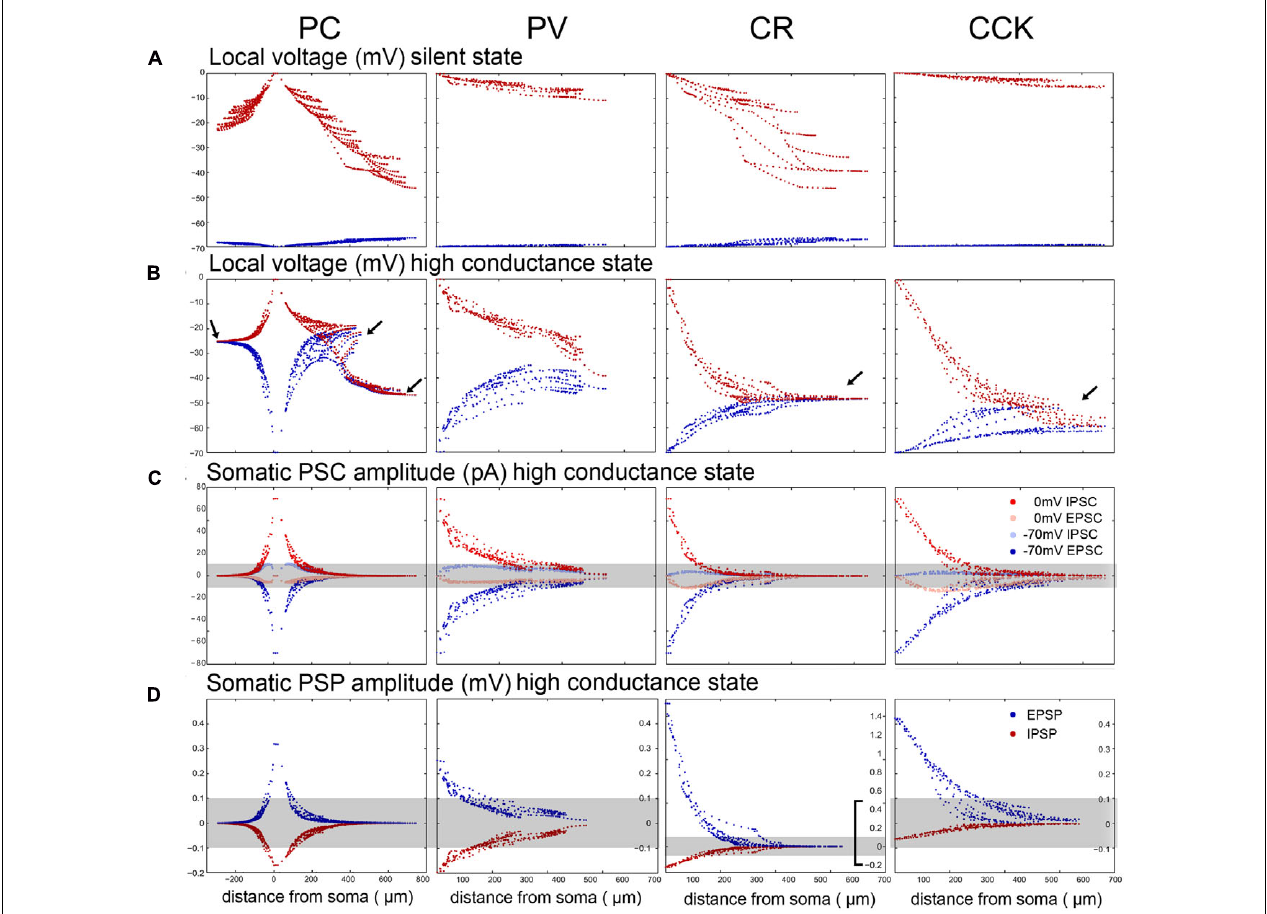
FIGURE 6 | VC measurement errors and somatic potentials are different in the 4 modeled neuron types. (A) The somata of the model neurons were clamped either to − 70 mV (dark red) or to 0 mV (dark blue) in the SS to show the breakdown of local clamped potential in different compartments. The breakdown is more severe when trying to clamp to 0 mV in all cell types, and it is much stronger in the electrotonically extensive pyramidal and CR cells than in the compact PV and CCK cells. (B) The breakdown of VC is considerably stronger in the HCS for all cell types. In the compact PV neuron the error is still relatively small. However, for the other cells the voltage converges over a short distance toward the equilibrium potential set by the local excitatory/inhibitory ratio (arrows). In the case of the relatively compact CCK cell the voltage converges toward a relatively negative potential because this cell receives the highest ratio of dendritic inhibition (see Figure 3 ). For PCs the convergence point is different for the oriens/radiatum dendrites and the lacunosum-moleculare dendrites, since the E / I ratio is different. (C) Comparison of somatically recovered EPSC and IPSC amplitudes at − 70 and 0 mV (the results for charge are quite similar, and are therefore not demonstrated). As emphasized by the gray stripe covering PSC amplitudes below the 10 pA detection threshold, a significant portion of the synaptic inputs are not detectable due to the rapid loss of current as we move away from the soma. With the exception of PV cells, inputs further away than 100–150 µ m are not detectable. (D) The distribution of somatically visible EPSP and IPSP amplitudes without somatic current injection (the somata sit at slightly depolarized membrane potentials where the interaction of excitatory and inhibitory bombardment clamps them). The gray stripe shows the PSP detectability threshold, which was set to 0.1 mV. Note that the scale is the same for the PC, PV, and CCK cells, but it is different for the CR cells that receive half a magnitude higher PSPs, due to the electrotonic organization of their